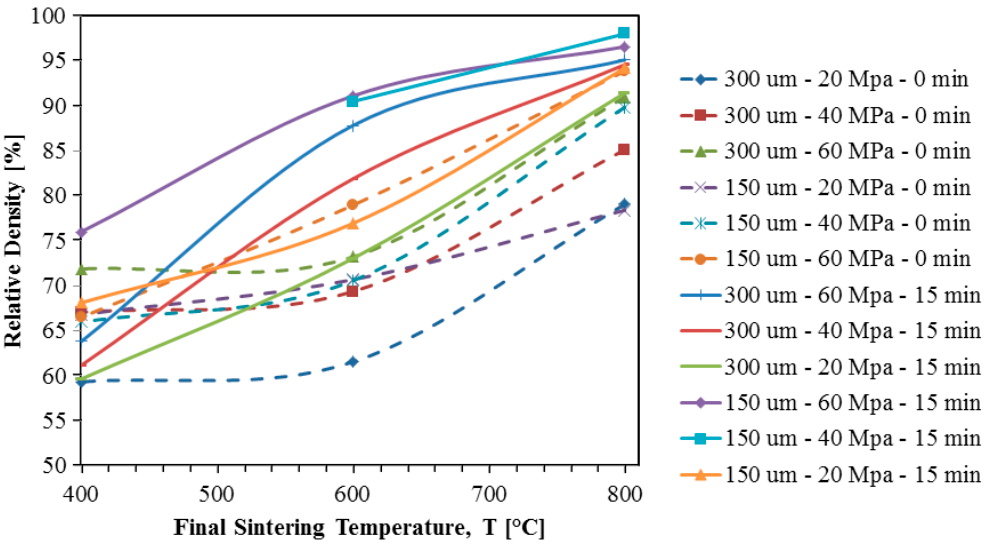
Figure 3. Relative density of all TNZT samples subjected to SPS with a heating rate of 100 °C/min, where the dashed line refers to the cases without the holding time, and the solid line with 15 min of holding time.